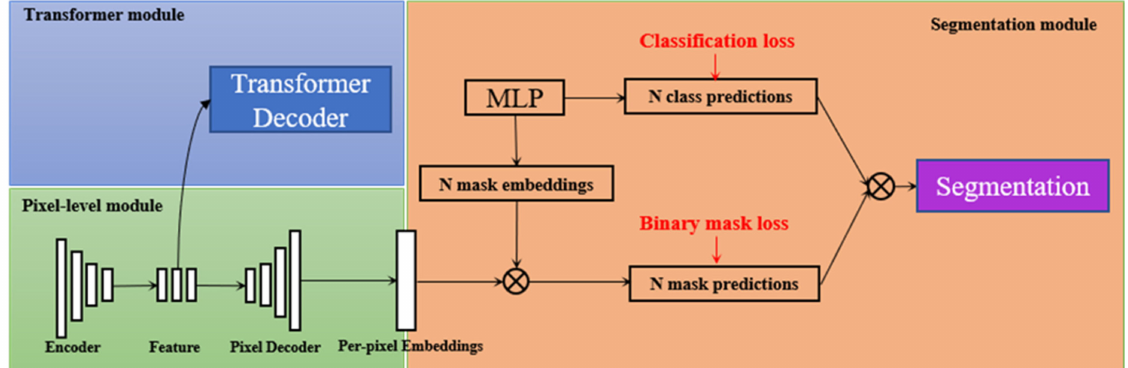
Figure 3. Overview of the MaskFormer.